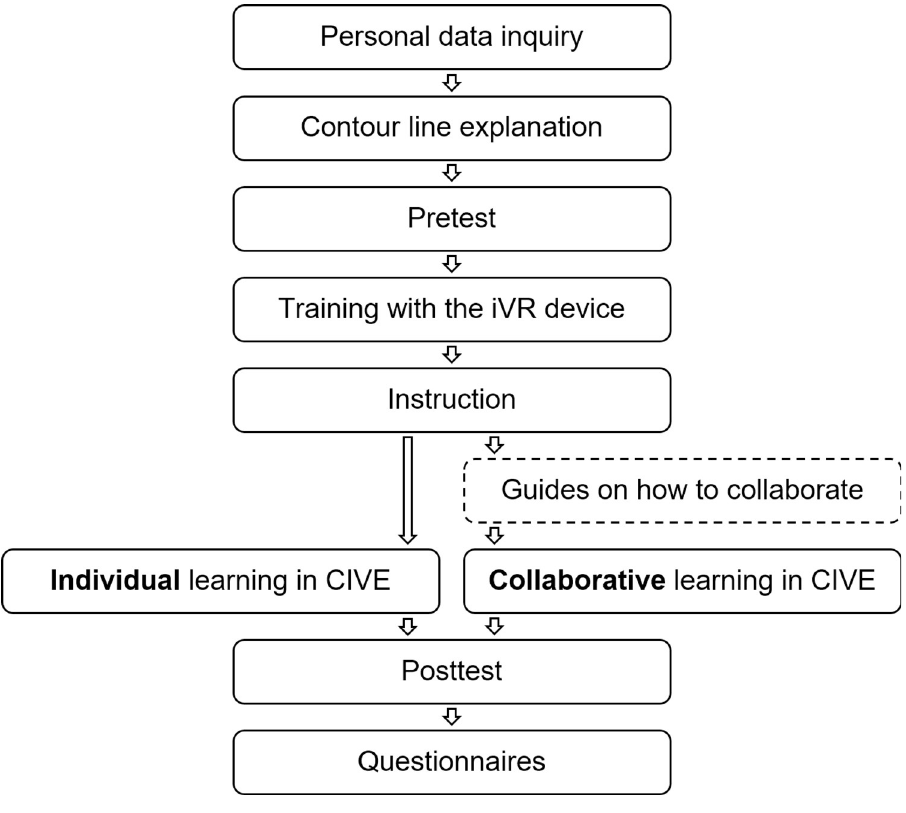
Fig 4. Overview of the research procedure